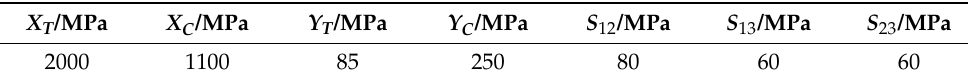
Table 3. Hashin damage parameters of the circuit boards [23].